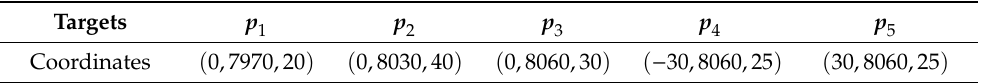
Table 2. The coordinates of the false point target.